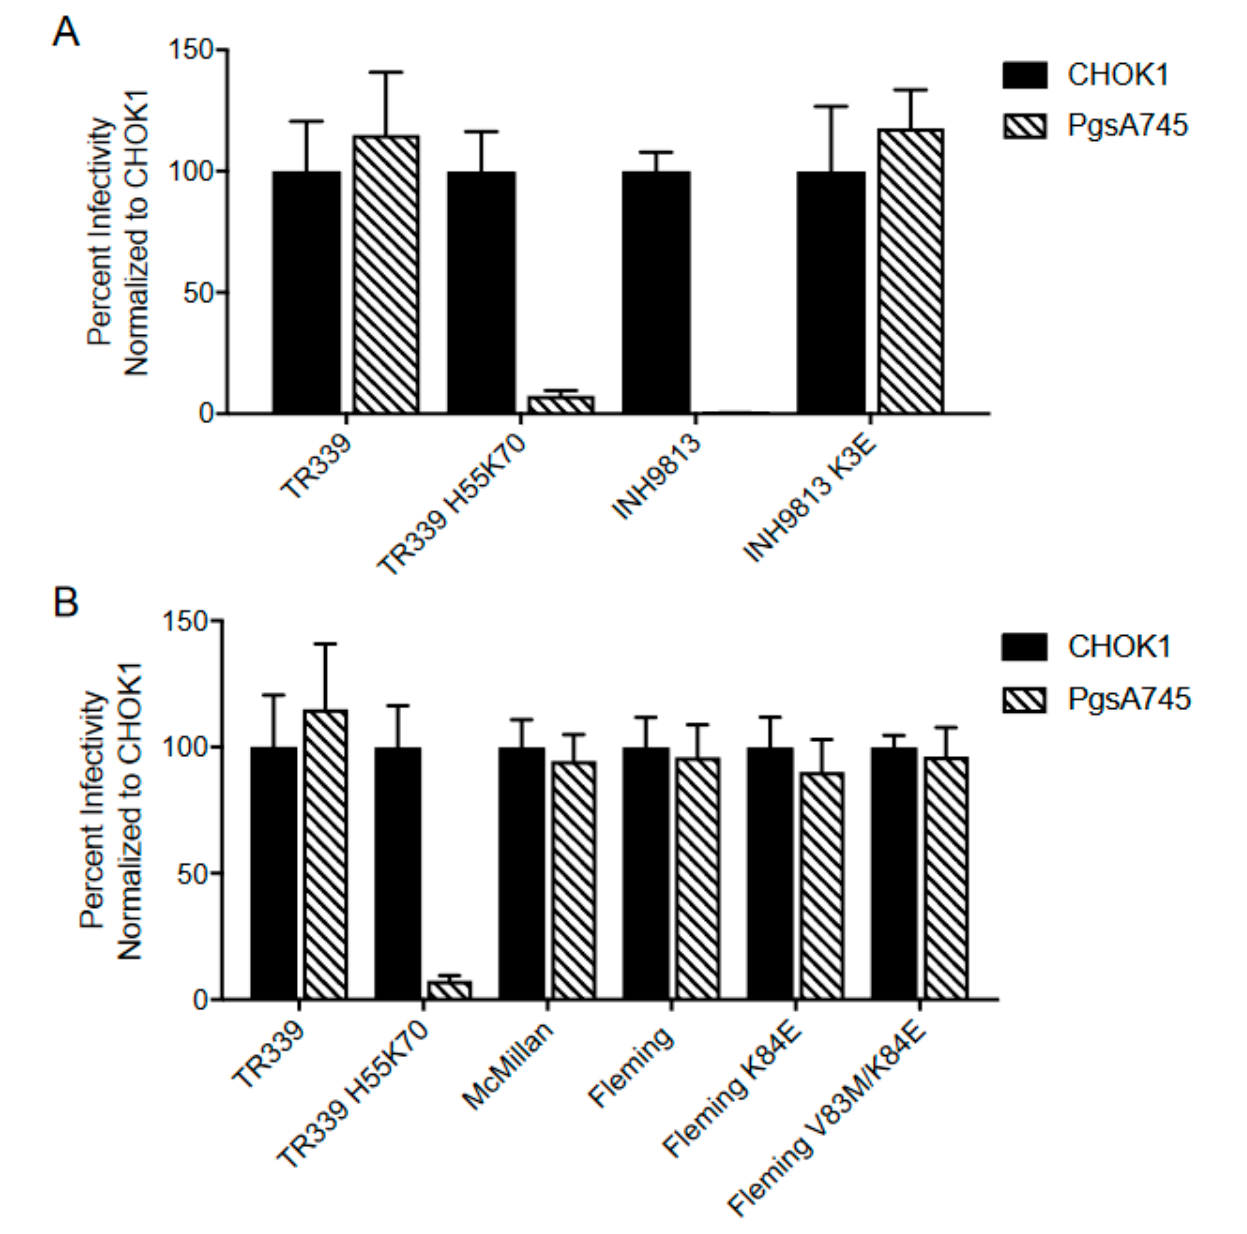
Figure 5. Relative infectivity of the indicated VEEV ( A ) and WEEV ( B ) viruses on WT CHOK1 and GAG-deficient pgsA745 cells. SINV TR339 and H55K70 are included as HS–independent and HS–dependent controls, respectively. GFP or mCherry expressing foci were enumerated with a fluorescence microscope. Infectivity was measured as the percentage of WT infectious units observed on each cell type with WT CHO cells set to 100%. Error bars are standard deviations and some are too small to be seen.